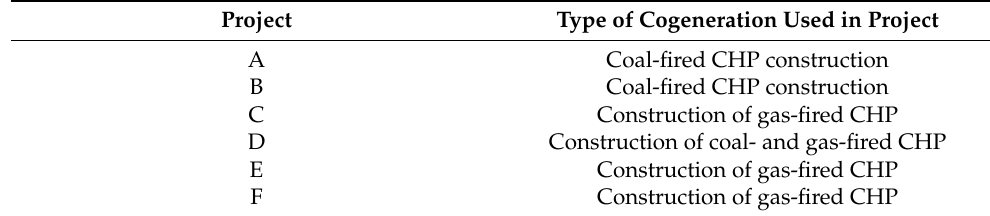
Table 4. Cogeneration projects under